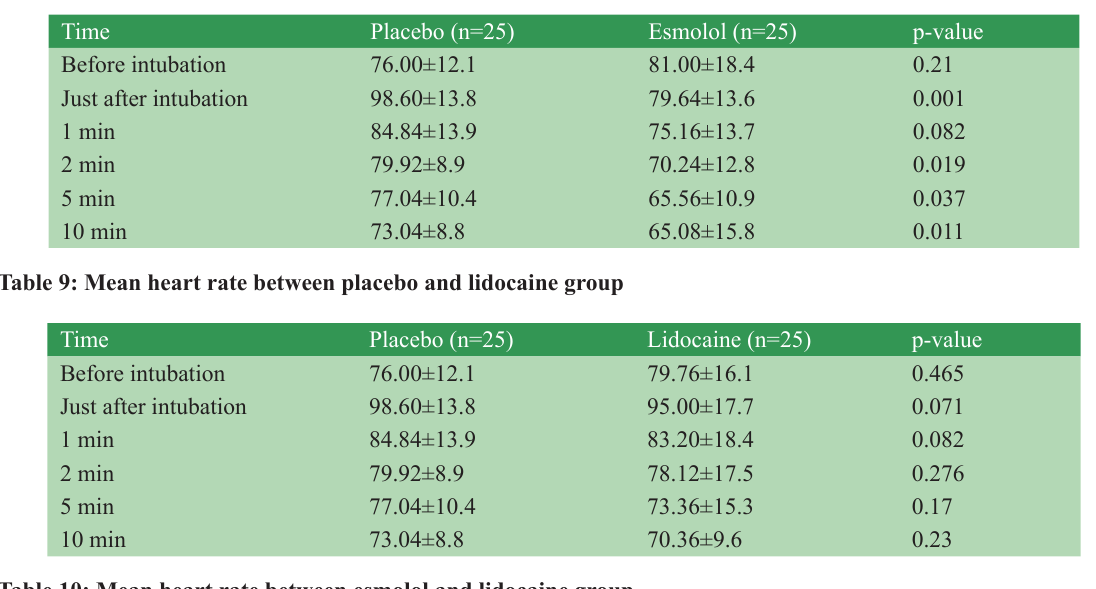
Table 10: Mean heart rate between esmolol and lidocaine group